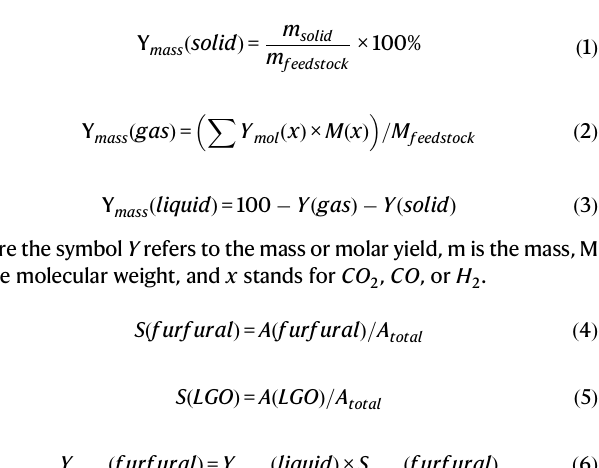
the adsorption of D-fructofuranose on Pd (111), PdO (101), and ZnSO 4 (111), respectively.Panel i forthefreeenergychangesfortheformationoffurfuralonthe surfaces of Pd, PdO, and ZnSO 4 along the reaction coordinate at 400°C. S8-S10 in panel ( i ) refer to the reaction steps No 8 – 10 speci fi ed in Fig.